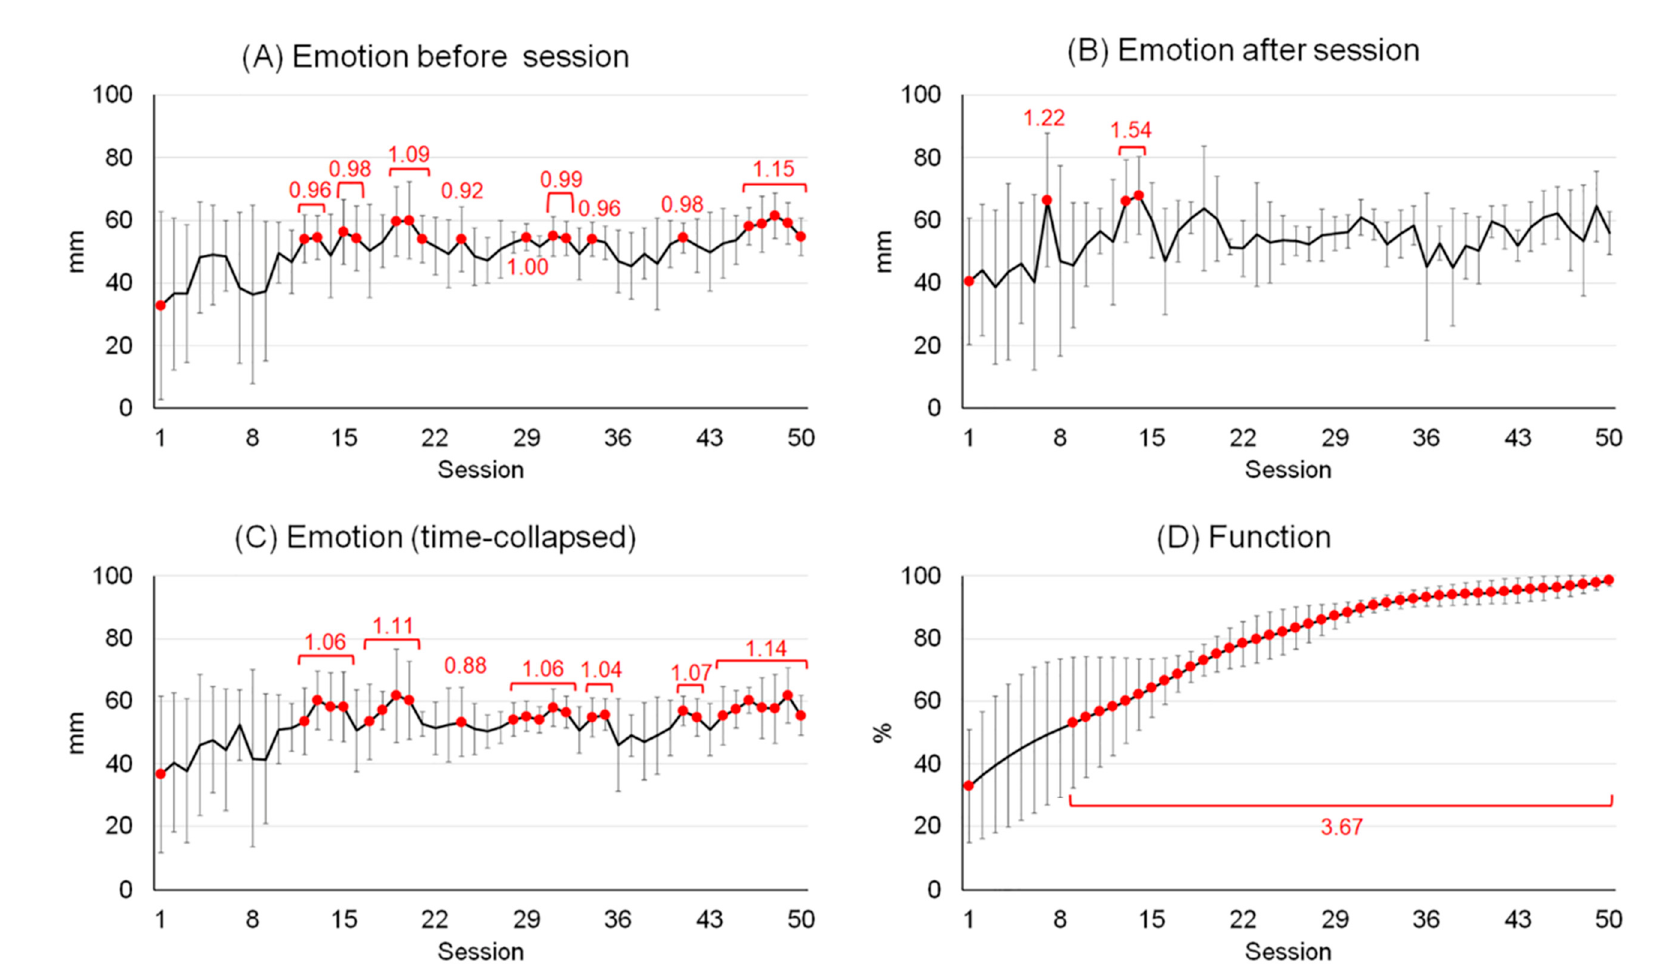
Figure 2. Emotional and functional ups and downs throughout the rehabilitation. All data were session-normalized into 50. Emotional profiles obtained before ( A ) and after ( B ) each session and combined ( C ); functional progressions during rehabilitation ( D ). Values are mean and 95% confidence intervals. The red dots represent statistical differences (post-hoc comparisons using Dunnett’s test) from the first session ( p < 0.10). The numbers in red font indicate the averaged effect size within the specified period.